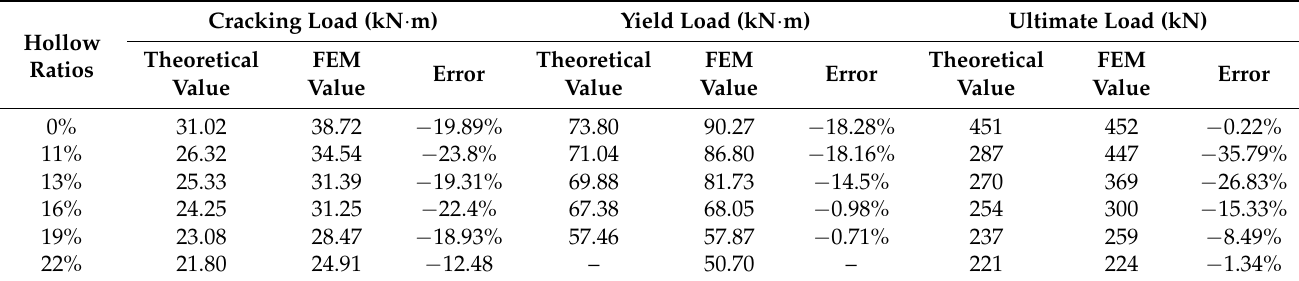
Table 7. Comparison of